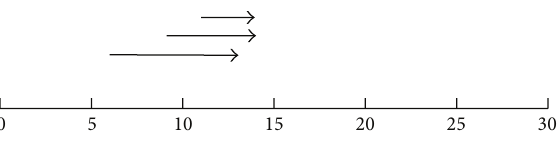
Figure 7: Data transfers with their start times and sharing period in the HEFT